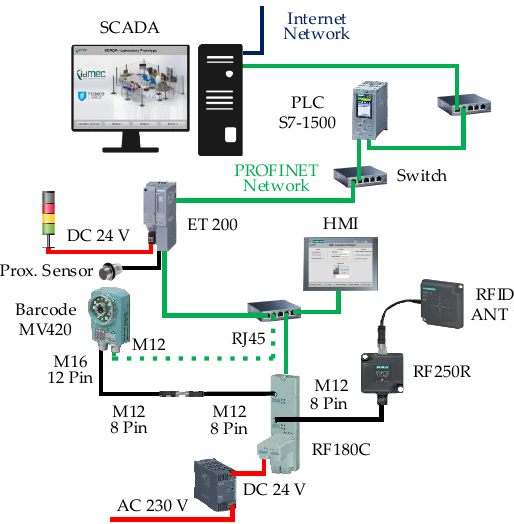
Figure 2. PLC Platform